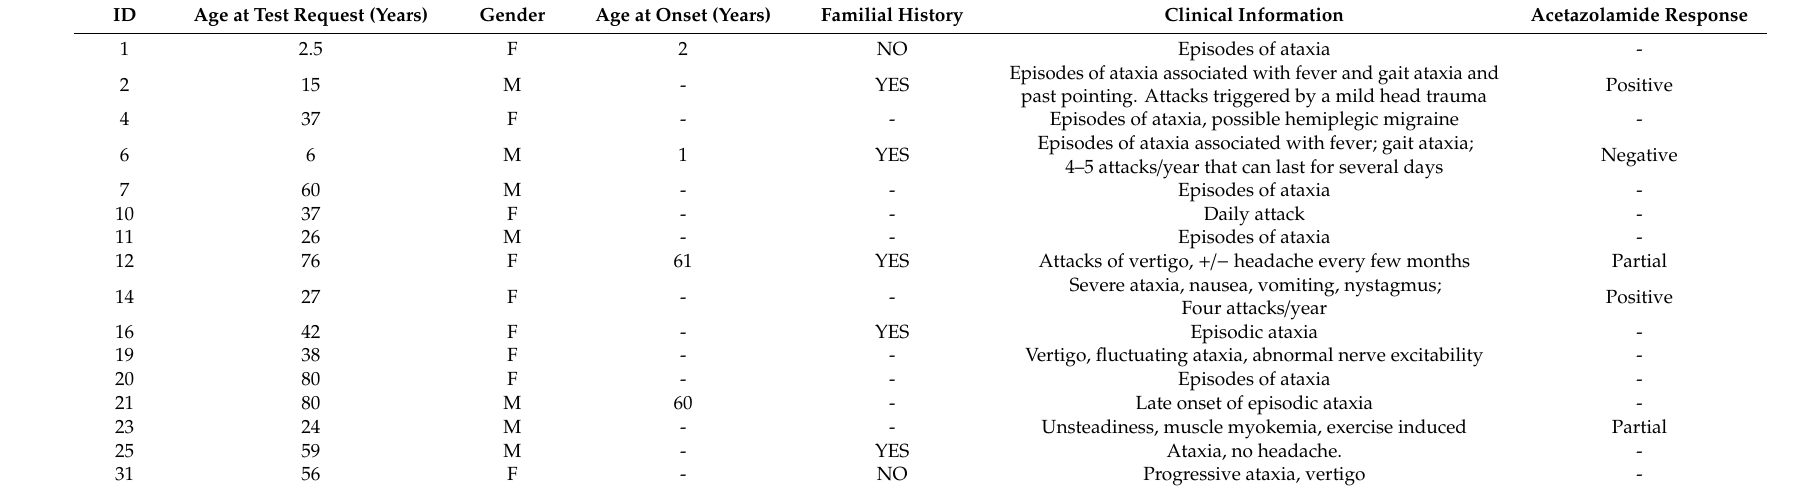
Table 1. The available clinical features of the 16 episodic ataxia